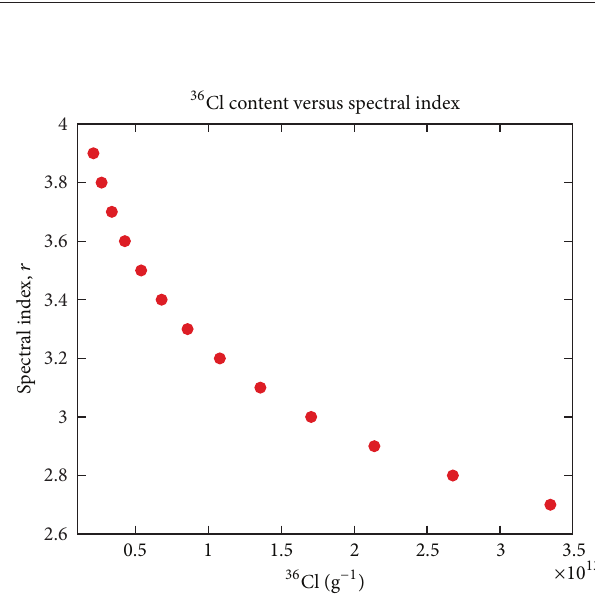
Figure 2: Predicted 36 Cl content in CAIs from energetic protons as a function of solar flare